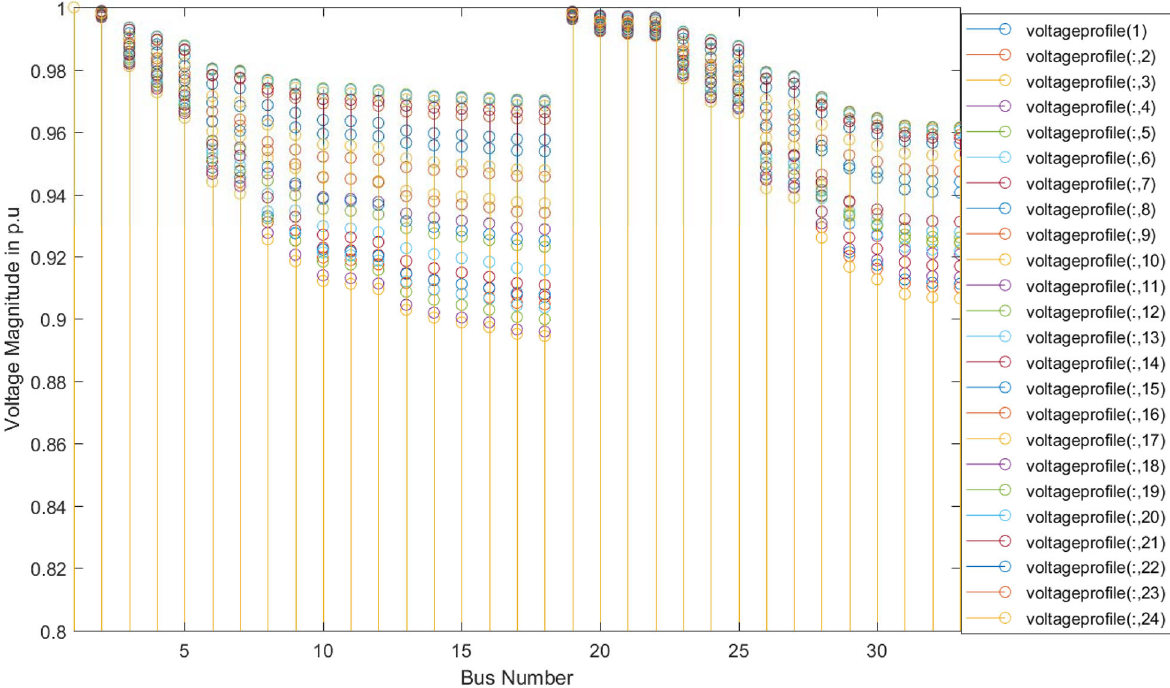
Fig. 4 Voltage profile of the system without EV load and